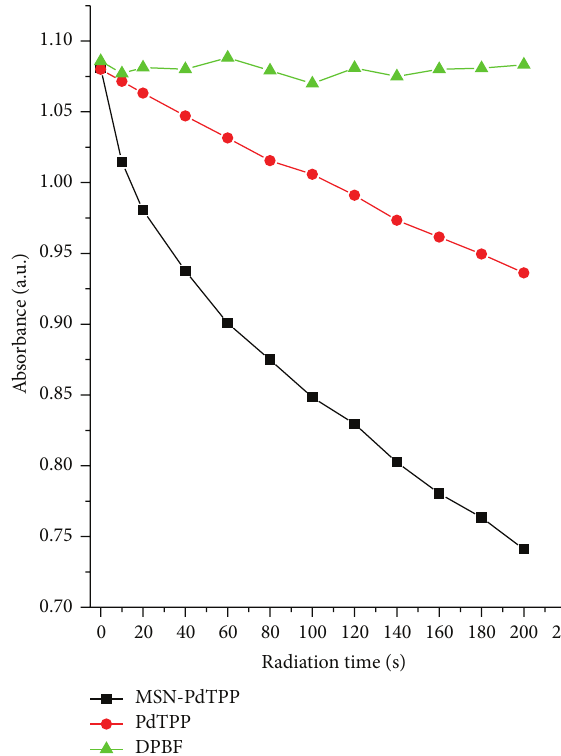
Figure 2: Decay curve of DPBF absorbance of 1 O 2 generated from PdTPP and MSN-PdTPP upon photoirradiation. Green line denotes DPBF with photoirradiation